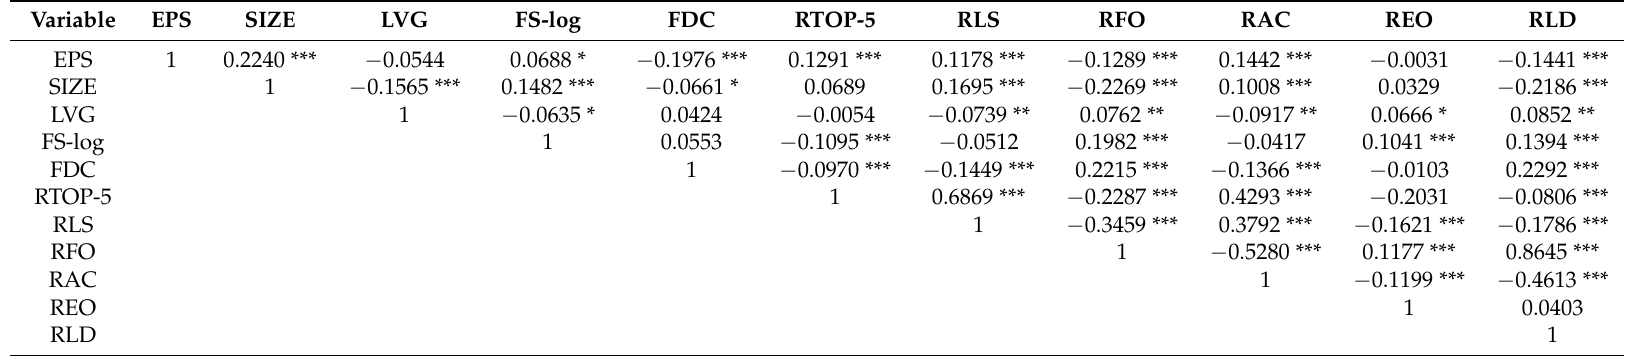
Table 3. Correlation